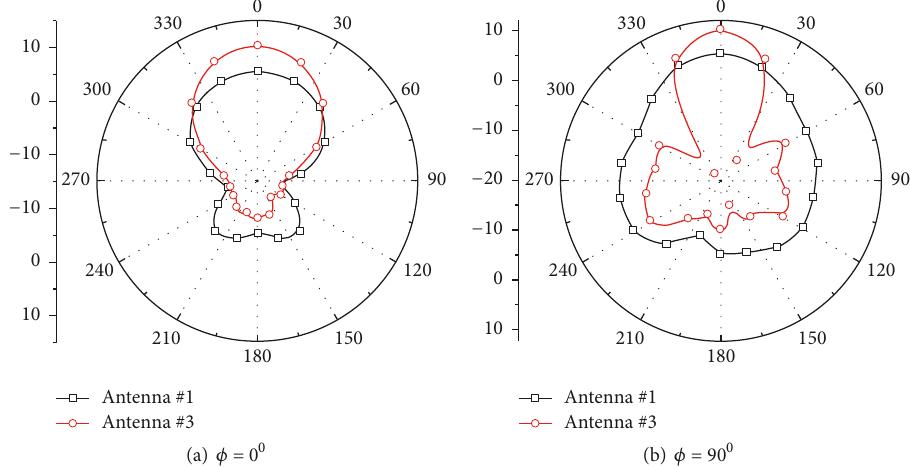
Figure 11: Gain total radiation pattern of Antenna #1 (without reflector) and Antenna #3 (reflector).